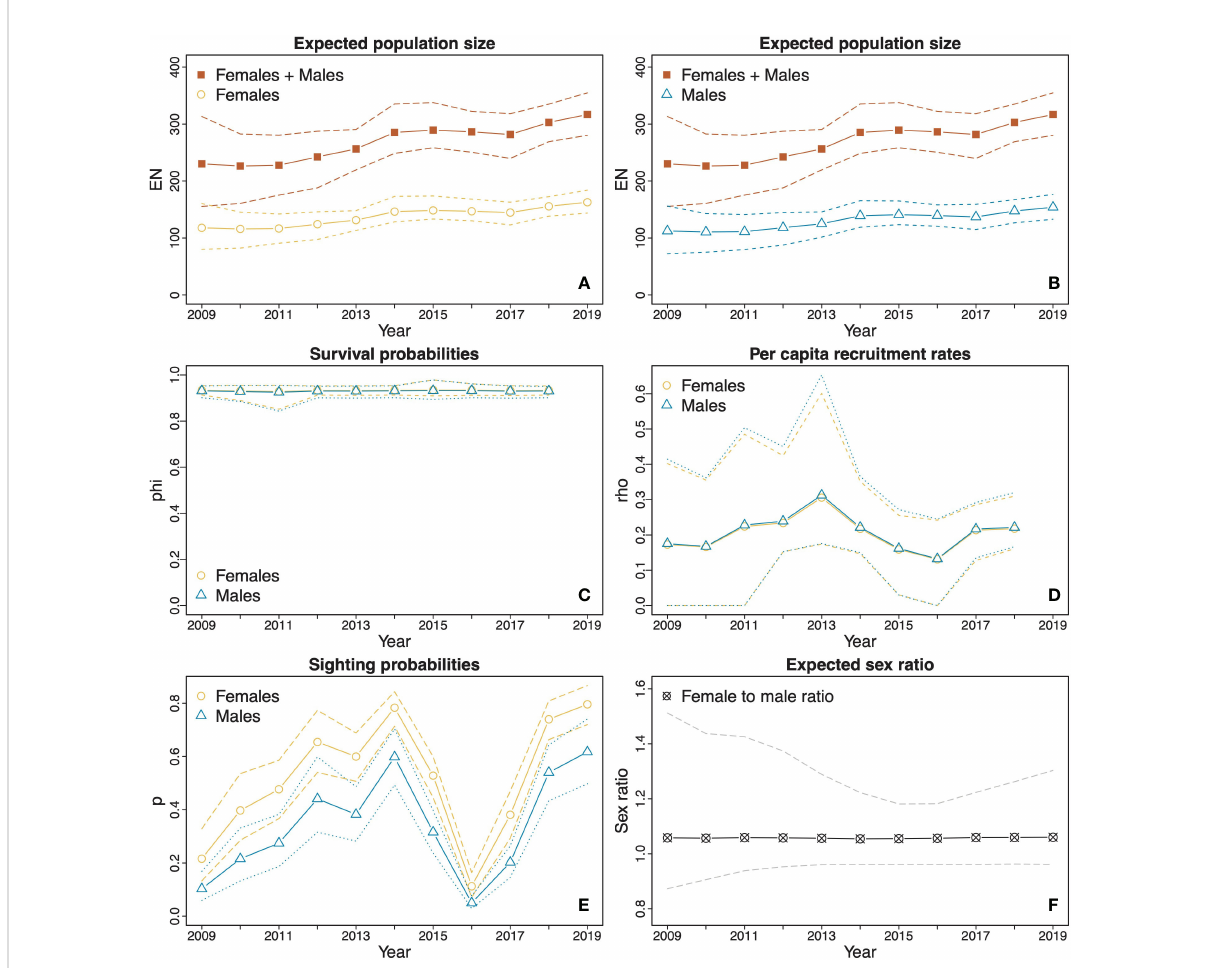
FIGURE 3 Estimates (solid lines) and CIs (dotted and dashed lines) derived from model averaging procedures for the M. alfredi subpopulation in the Dampier Strait MPA. (A and B) The estimated expected population sizes of females and males relative to the estimated expected overall population sizes of both sexes combined; (C) Survival probabilities of females and males; (D) Per capita recruitment rates of males and females; (E) Sighting probabilities of females and males; and (F) Expected female to male ratio. The orange lines represent female estimates, blue lines represent male estimates, and red lines represent total estimates of females and males. Black and grey lines represent sex ratio estimates (female to male). Dotted lines represent upper and lower con fi dence